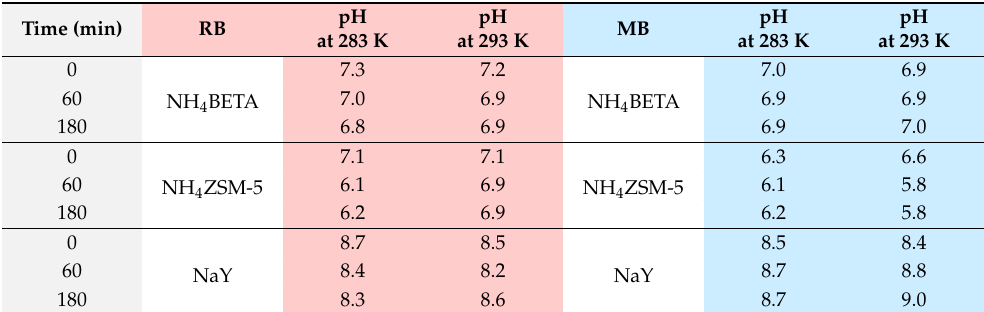
Table 1. The change in pH value of the solution during the photodegradation dyes (1.0 mg/dm 3 ) in the presence of 5.0 mg/cm 3 zeolite under UV radiation.